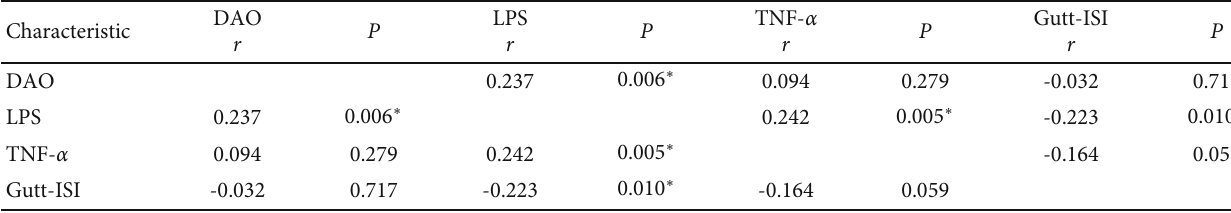
Table 4: Partial correlation analysis of Gutt-ISI with DAO, LPS, and TNF- α .